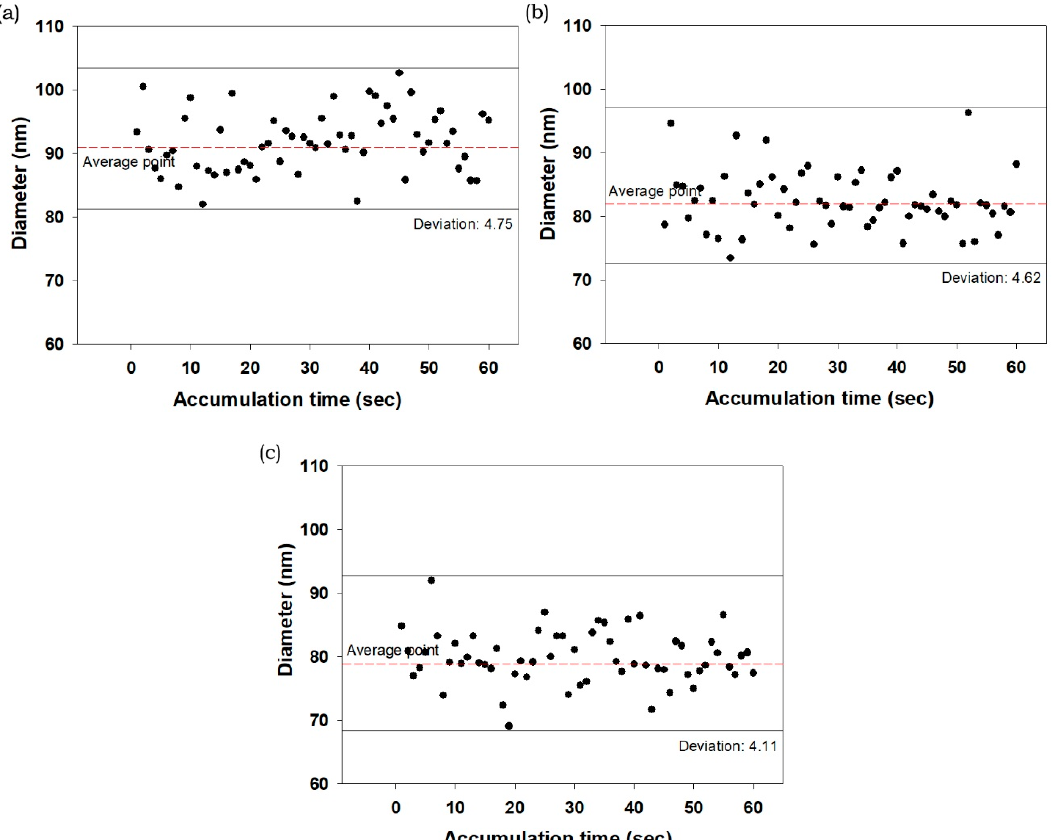
Figure 6. Results of particle size analysis after high-pressure dispersion at 345 × 10 5 Pa. Diameter distributions after ( a ) one dispersion pass as a function of time, ( b ) two dispersion passes as a function of time, and ( c ) three dispersion passes as a function of time.